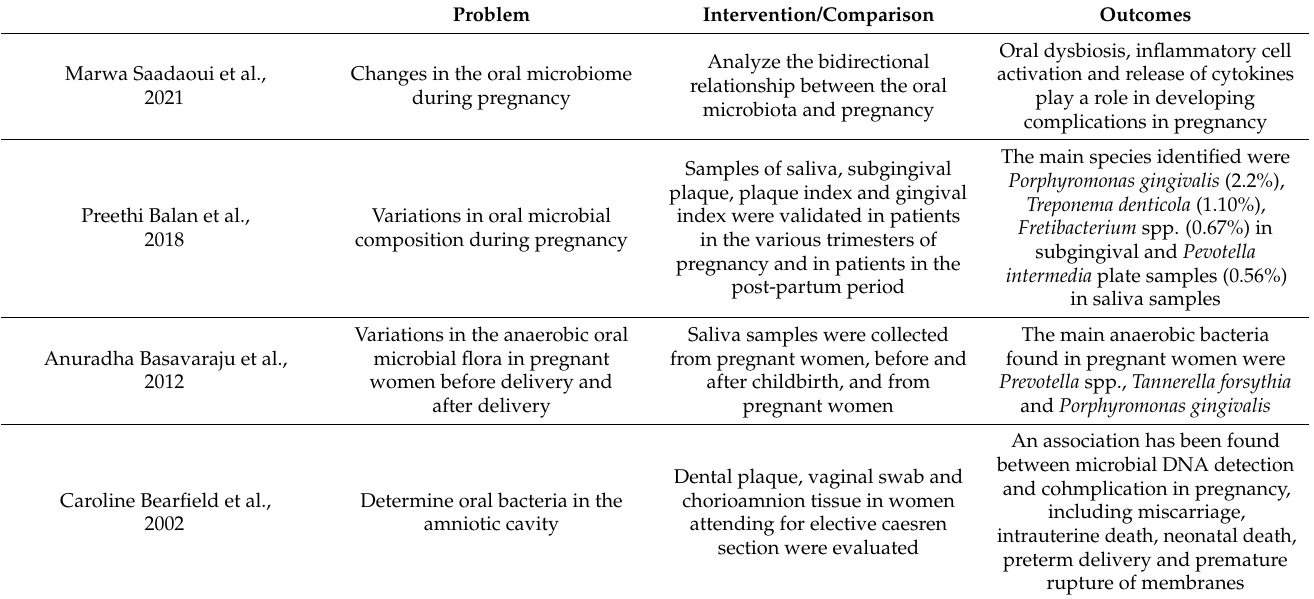
Table 1. Articles related to the change of oral microbiome in pregnant